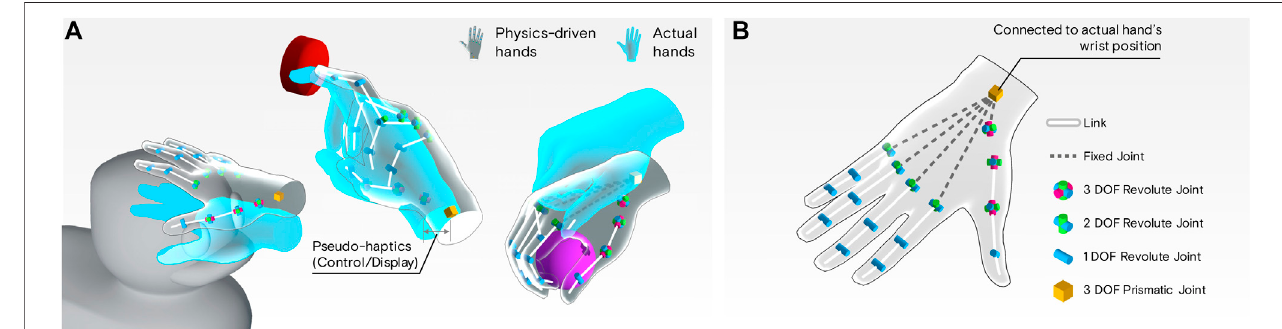
FIGURE 4 | Physics-driven hands. (A) Physics-driven hands shown in the following scenarios from left to right: (1) When pressing against a stationary object the physics-driven fi ngers conform along the object ’ s curvature while respecting joint limits. (2) When pressing on a button with a spring-like stiffness, the fi ngers do not buckle under the constraints. The whole hand is also offset according to the force resisting the hand, resulting in a pseudo-haptic illusion. (3) When grasping and lifting objects,the fi ngersrespectthegeometryoftheobjectandconformalongtheshapeoftheobject.Gravityacting ontheobjectandinertiaalsodictatesthepseudo- haptic illusion. (B) Adiagram showingthearticulated bodiesand theirrespectivejoints (Thehand ’ sbaseskeletonisidenticaltotheOVRHand skeletonprovided withthe Oculus Integration